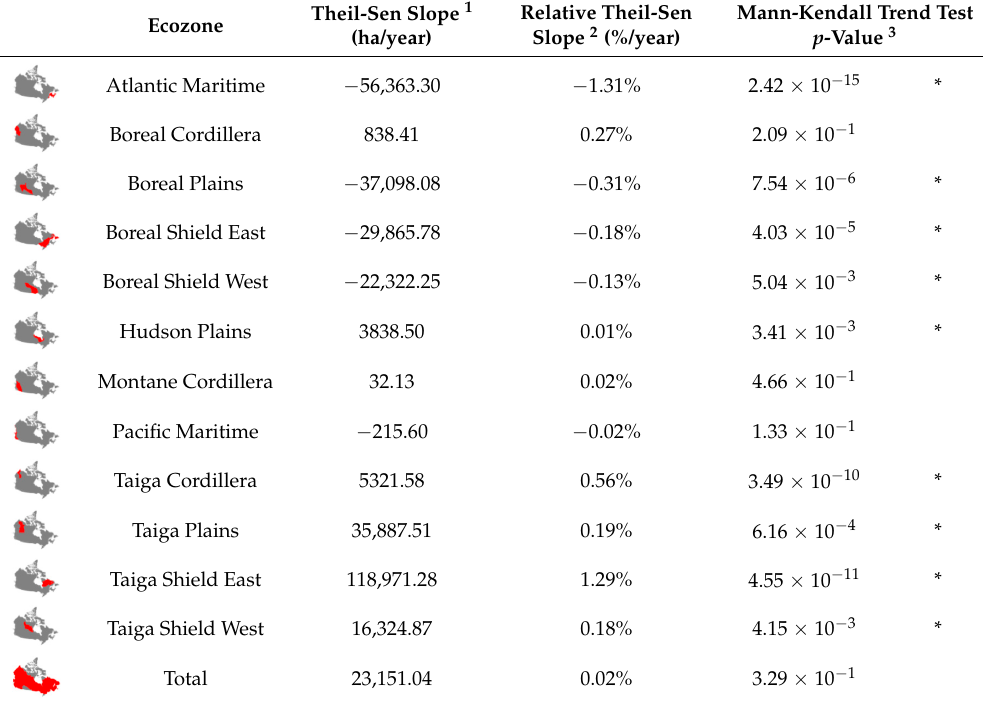
Boreal Shield West − 22,322.25